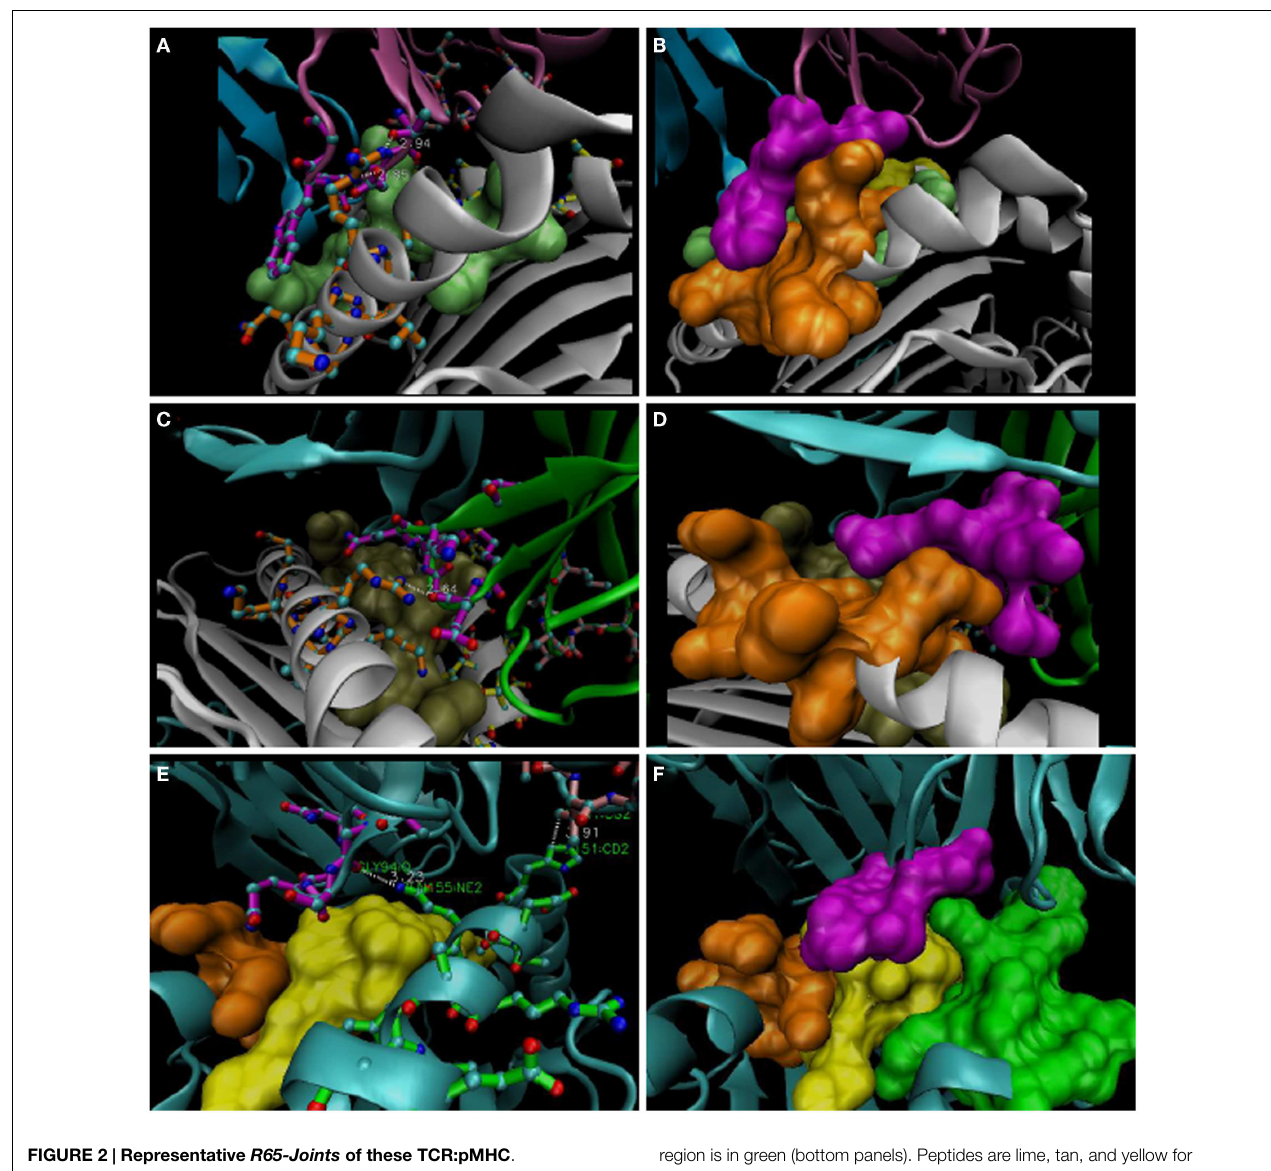
FIGURE 2 | Representative R65-Joints of these TCR:pMHC . (A,B) 1AO7; (C,D) 1BD2; (E,F) 2VLR. VMD software used to isolate structures and make bond measurements; “licorice” representations are shown at left and “surf” representations are shown on the right . Docking CDR3 α a.a. are in magenta (V α : in magenta, 1AO7; green, 1BD2; cyan, 2VLR); the R65 motif is in orange, and the H151-A158